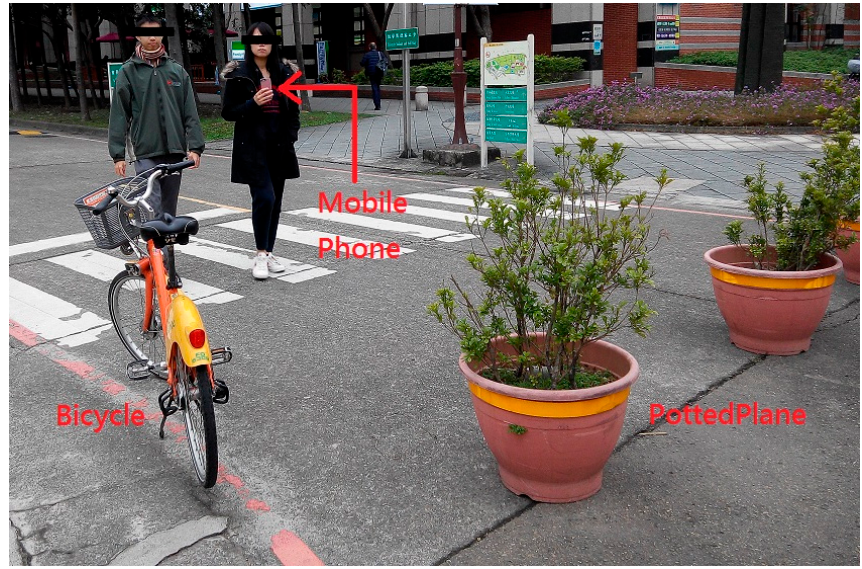
Figure 20. Photo of on-site testing.